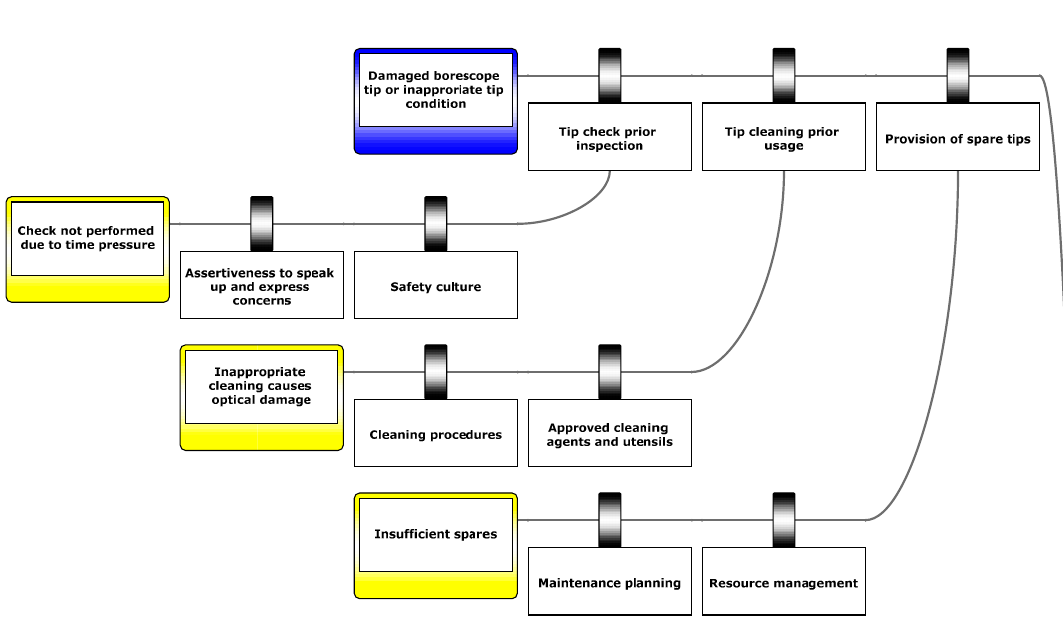
Figure A2a. “Damaged borescope tip or inappropriate tip condition” threat path. Aerospace 2019 , 6 , 110